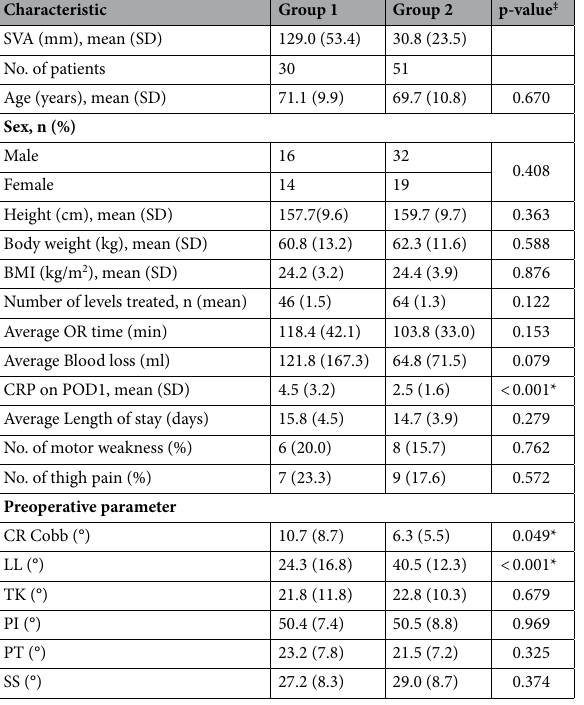
Table 2. Comparison of demographic and treatment data between two groups. SD standard deviation. *Statistically significant. ‡ Comparison between two